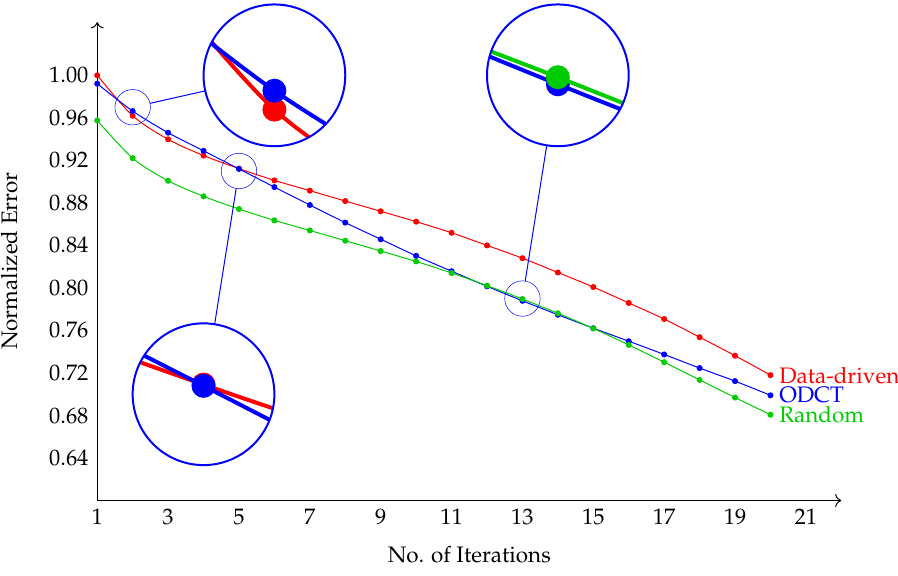
Figure 13. Iterative algorithm convergence: l 2 norm of the Γ matrix coefficients (see Equation (8)) versus number of iterations for three different chosen dictionaries: DD (blue), ODCT (red), RD (green).